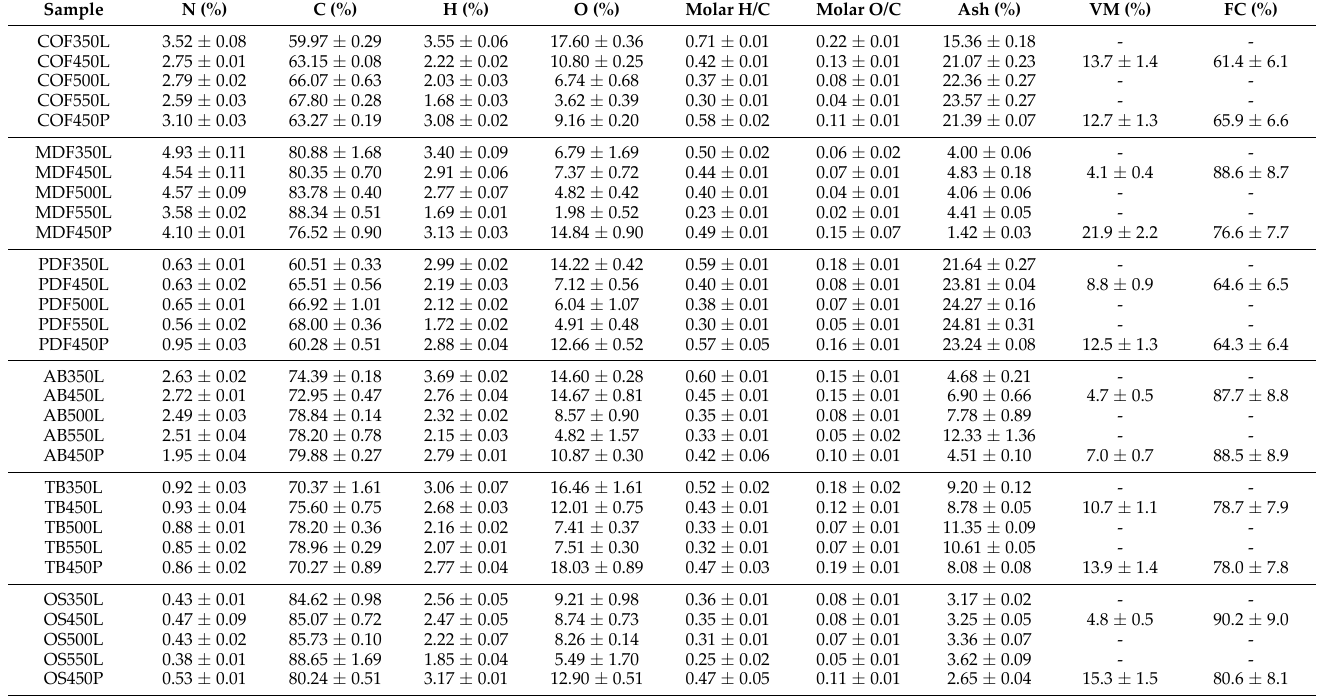
Table 3. Proximate and ultimate analysis of the biochars. VM = volatile matter, FC = fixed carbon, L = lab‑scale reactor, P = pilot‑scale reactor, COF = coffee husks, MDF = medium‑density fiberboard, PDF = palm date fronds, AB = AB wood waste, TB = tree bark, and OS = olive stones. The blanks (‑) in VM and FC indicate that these samples were not measured. Results of proximate and ultimate analysis for MDF were previously published